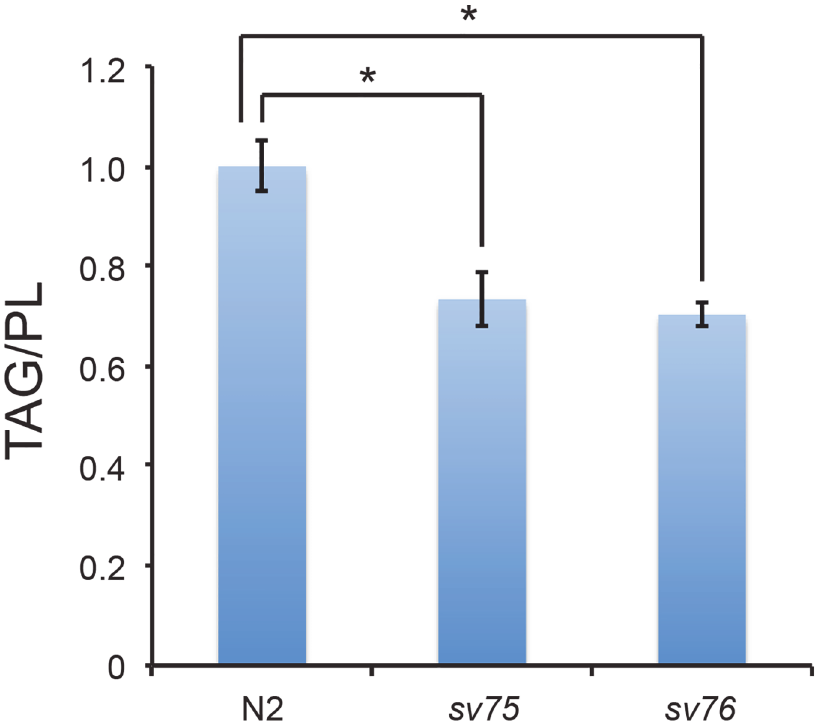
Fig 2. sv75 and sv76 mutant worms have lower triglyceride/phospholipid ratios than the N2 wild-type strain. The graph shows normalised ratios of total triglycerides (TG) to total phospholipids (PL) in extracts from young adult hermaphrodites. Levels of triglycerides and phospholipids relative to C13:0 and C17:0 standards respectively were determined by gas-liquid chromatography. Three extracts were examined for each genotype. Error bars represent 95% confidence intervals. * Indicates significant difference in the means determined by one-way ANOVA and Bonferroni test for differences between means ( σ = 0.05).